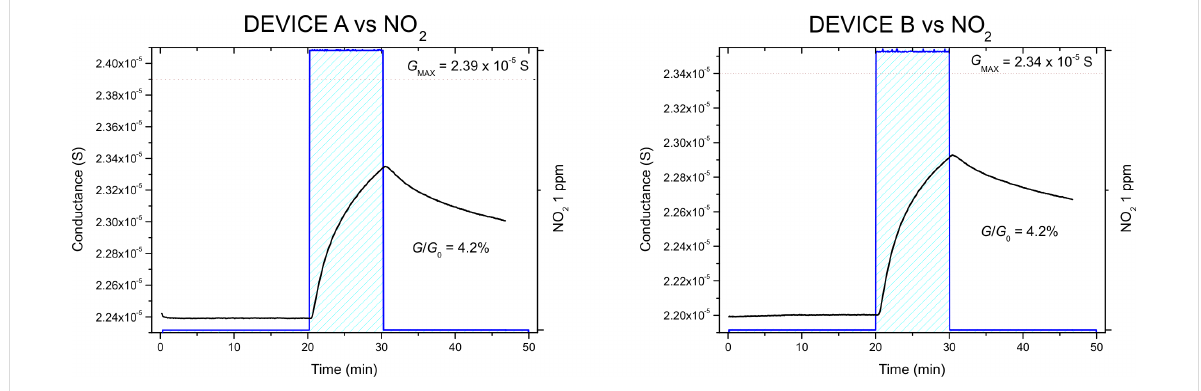
Figure 3: Dynamic response of devices A (left) and B (right) during the exposure to 1 ppm of NO 2 .